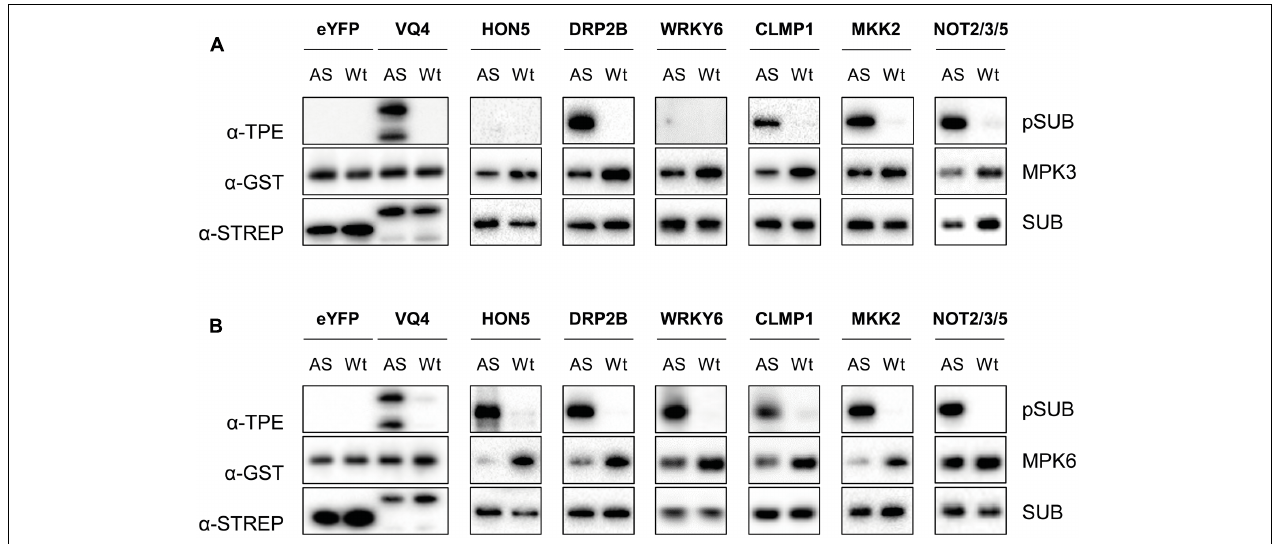
FIGURE 5 | In vitro thiophosphorylation assay of MPK3/6. (A) Thiophosphorylation assays of GST-tagged wild type (Wt)- and analog-sensitive (AS)-MPK3 in the presence of Bn-ATP γ S as cofactor. Tested StrepII-tagged substrates (SUB, e.g., eYFP, VQ4, HON5, DRP2B, WRKY6, CLMP1, MKK2, and NOT2/3/5) were purified from cell-free in vitro transcription-translation reactions using tobacco BY-2 cell lysates. Western blotting analysis, and immunodetection with specific antibodies was performed to check equal amounts of kinase ( α -GST) and substrate ( α -STREP) in each reaction and to examine phosphorylation of substrates ( α -TPE). (B) Same as in (A) but using Wt- and